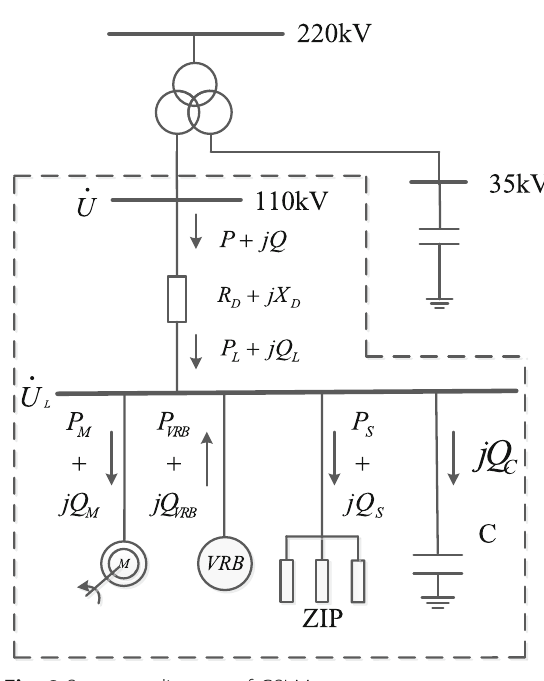
Fig. 8 Structure diagram of GSLM